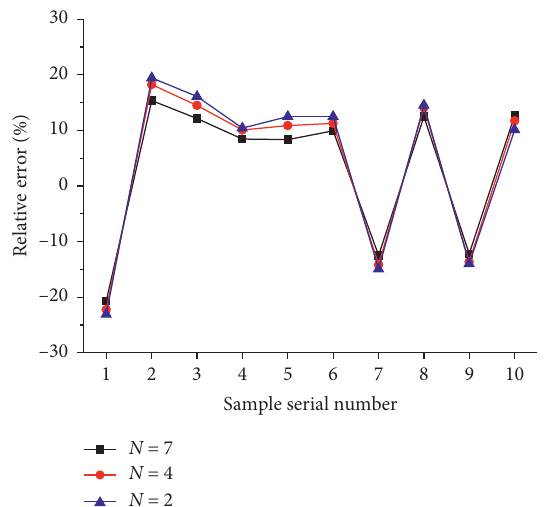
Figure 12: The prediction error curve of H when the number of BP neural network neurons was 2, 4, and 7, respectively.